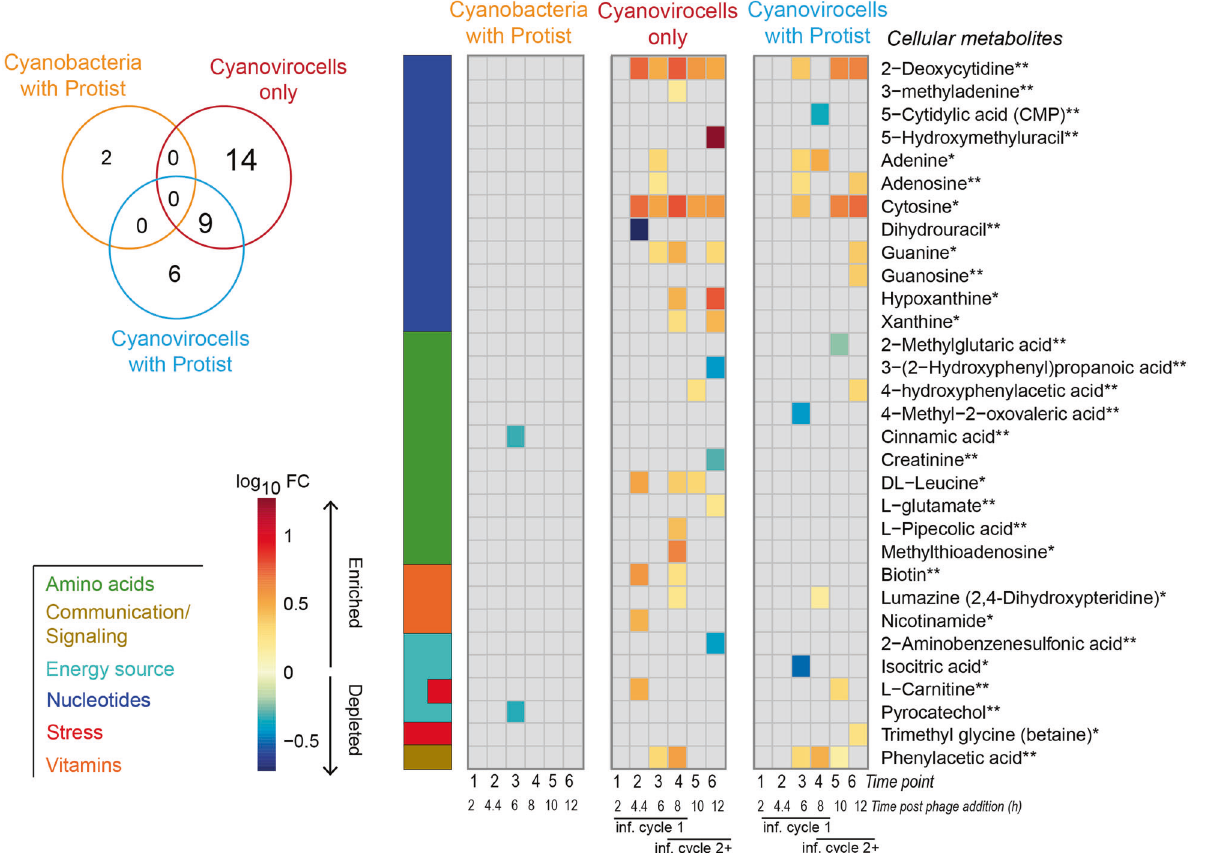
Fig. 5 Changes in the extracellular metabolome of cyanobacteria across three treatments. Venn diagram: number of signi fi cantly changing metabolites detected extracellularly in each treatment. Heatmap: abundance of all signi fi cantly changing metabolites detected extracellularly with each treatment, in log 10 -fold change (FC) of the values in the treatment relative to the uninfected control. The colored bar on the left represents the class to which the metabolites belong. The con fi dence in metabolite detection is indicated by an asterisk next to the name. Con fi dence of level 1 (1 asterisk) indicates that the compound met all three identi fi cation criteria in positive or negative mode (i.e., retention peak, mz, and msms), whereas level 2 (2 asterisks) denotes two of the three criteria were met. The time course for cyanovirocells and cyanovirocells with protist captures more than one infection cycle: the fi rst one with the phages added at the start of the experiment ( “ inf. cycle 1 ” ) and the ones that follow once the phages are released from “ inf. cycle 1 ” and infect new cells ( “ inf. cycle 2 + ” ). amino acids ( n = 4), nucleotides ( n = 3) and vitamins ( n = 1), thus supporting prior fi ndings that viral lysis releases organic matter [59, 109, 111]. Together, the exometabolite data from the protist- free cyanovirocell treatment suggests that (i) stress and commu- nication molecules were unique to intact cells, as they were found only in the fi rst infection cycle, and (ii) cyanovirocell-derived amino acids, nucleotides, and vitamins are organic resources available to a microbial community pre- and post-cell lysis. Finally, we evaluated the 15 exometabolites differentially detected in the cyanovirocells co-cultured with protists relative to the cyanobacteria only control, 9 of which were shared with the cyanovirocells only treatment (and were also enriched), and 6 of which were new (2 enriched, 4 depleted). The decrease in the number of enriched exometabolites in the cyanovirocells with protist treatment relative to the cyanovirocells only treatment suggests that either in response to the protist the cyanovirocells were decreasing export/diffusion, or that one of the microbes (cyanobacterial cells, cyanovirocells, or protists) were utilizing the metabolites. For example, Sul fi tobacter virocells [59] have both been shown to uptake exometabolites, and both Synechococcus and the protist are capable of directly importing dissolved molecules [110, 112]. The 4 exometabolites were derivatives of a transcriptional changes, (ii) expected phage AMG-driven meta- nucleotide, two amino acids, and a TCA cycle metabolite bolic reprogramming (reviewed in [31, 78]), and (iii) no signi fi cant intermediate from which bacteria obtain energy. All but one were